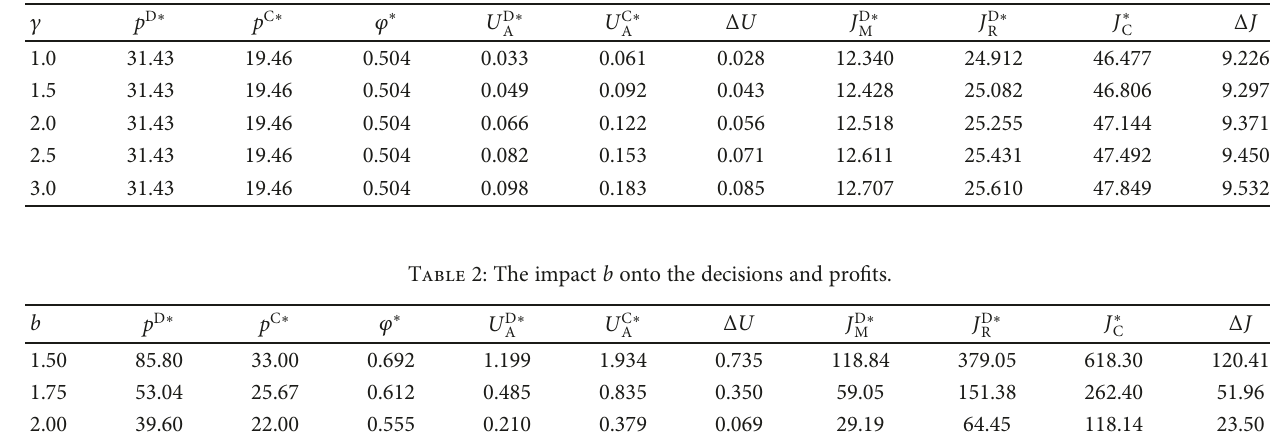
Table 1: The impact γ onto the decisions and pro fi ts.